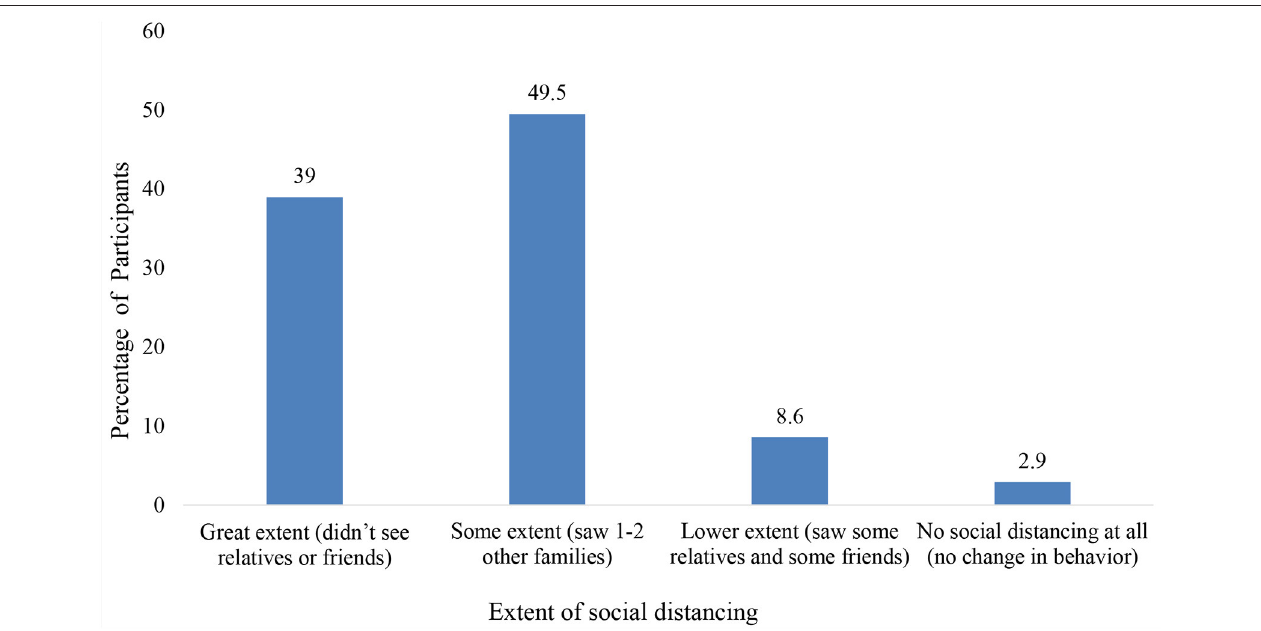
FIGURE 6 | Caregivers’ or parents’ perception of the family’s social distancing behavior during